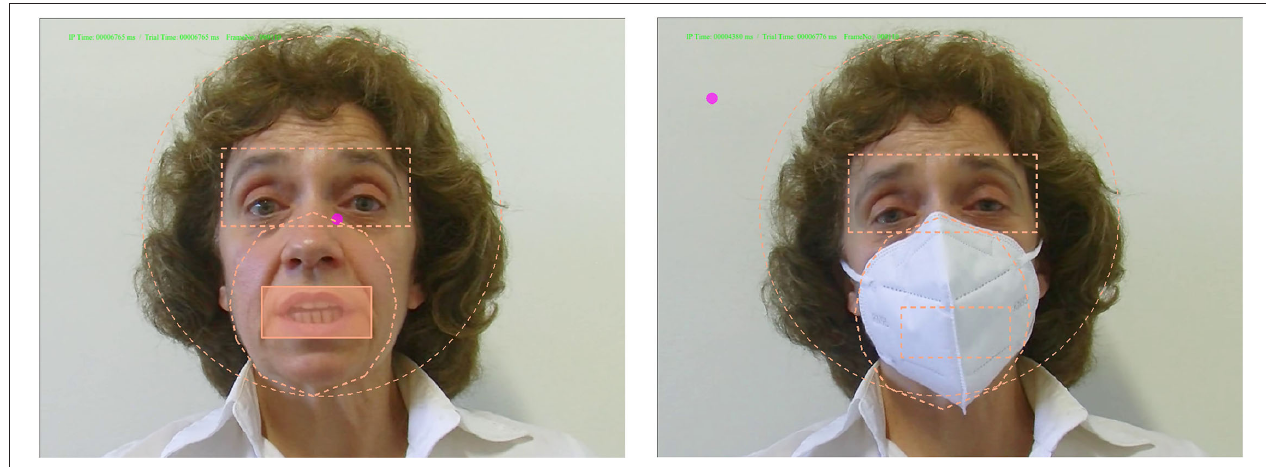
FIGURE 6 | Example frames demonstrating areas of interest.